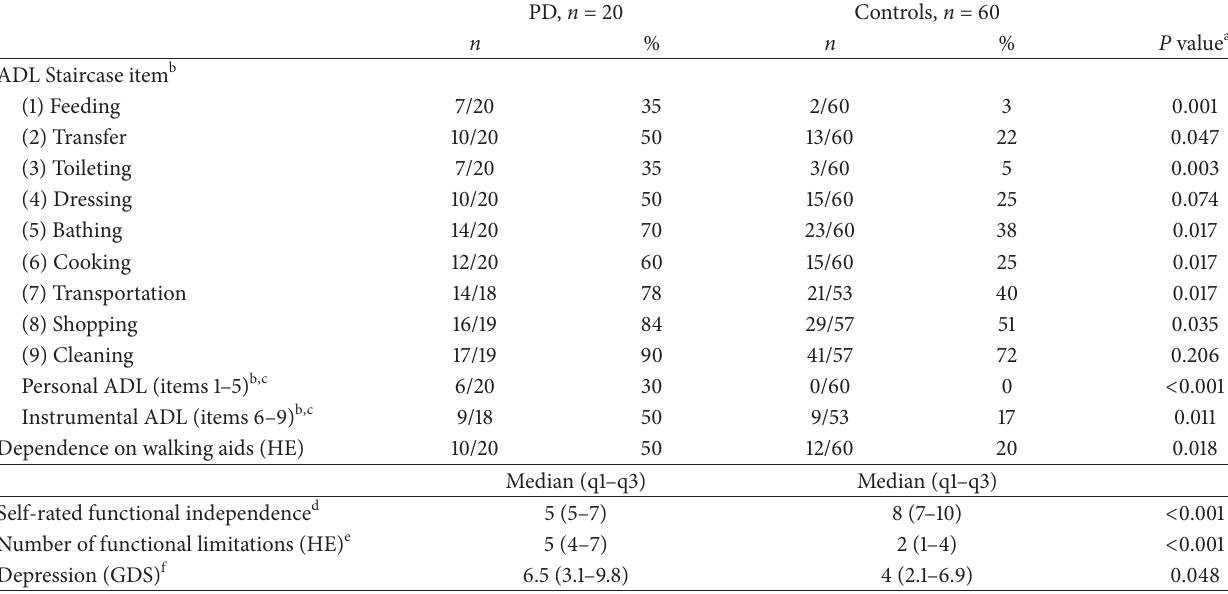
Table 3: Comparison of aspects of health between very old people reporting having Parkinson’s disease (PD) ( n = 20) and controls not reporting having PD ( n =